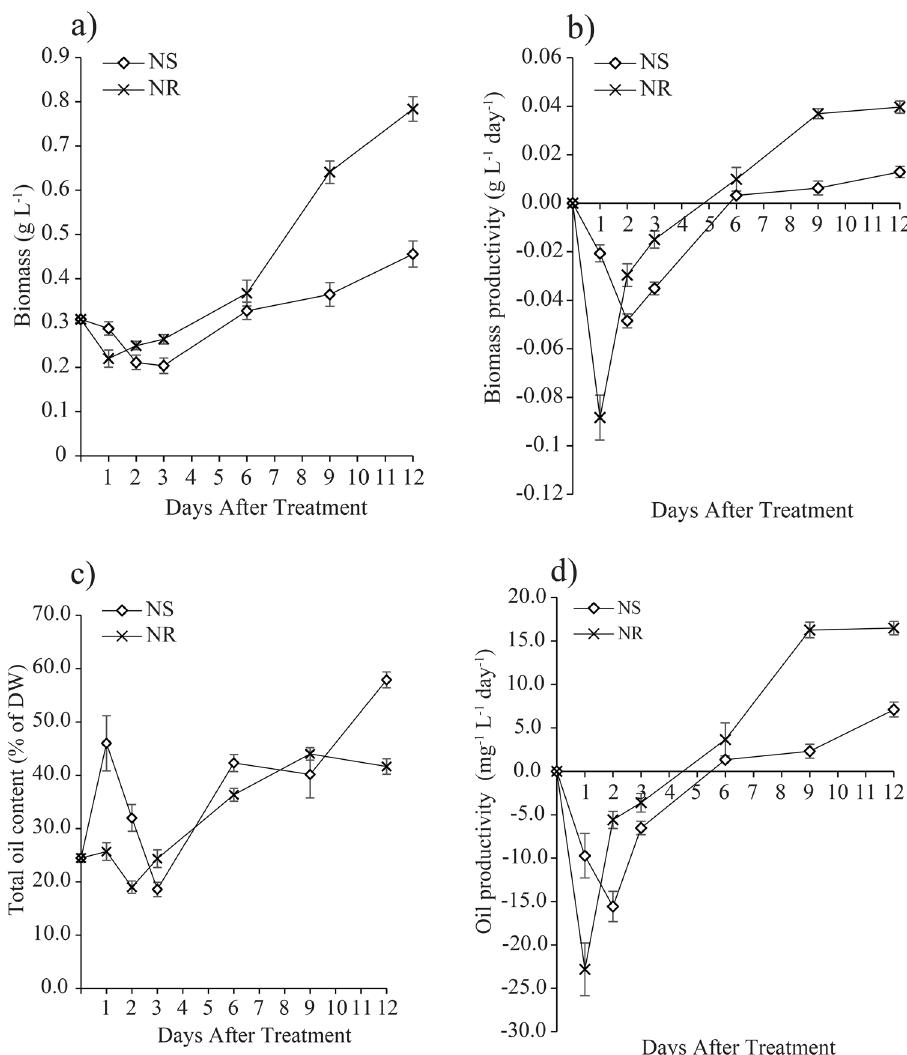
Figure 2. Effects of nitrate availability on M. gracile SE-MC4 cultivation during early (day 1, 2 and 3), mid (day 6 and 9) and late (day 12) treatment periods. ( a ) Biomass of M. gracile under nitrate-starve (NS) and nitrate-replete (NR) conditions. ( b ) Biomass productivity of M. gracile under NS and NR conditions. ( c ) Total oil content of M. gracile under NS and NR conditions. ( d ) Oil productivity of M. gracile under NS and NR conditions. The values are presented as means ± standard deviation (SD) (n =